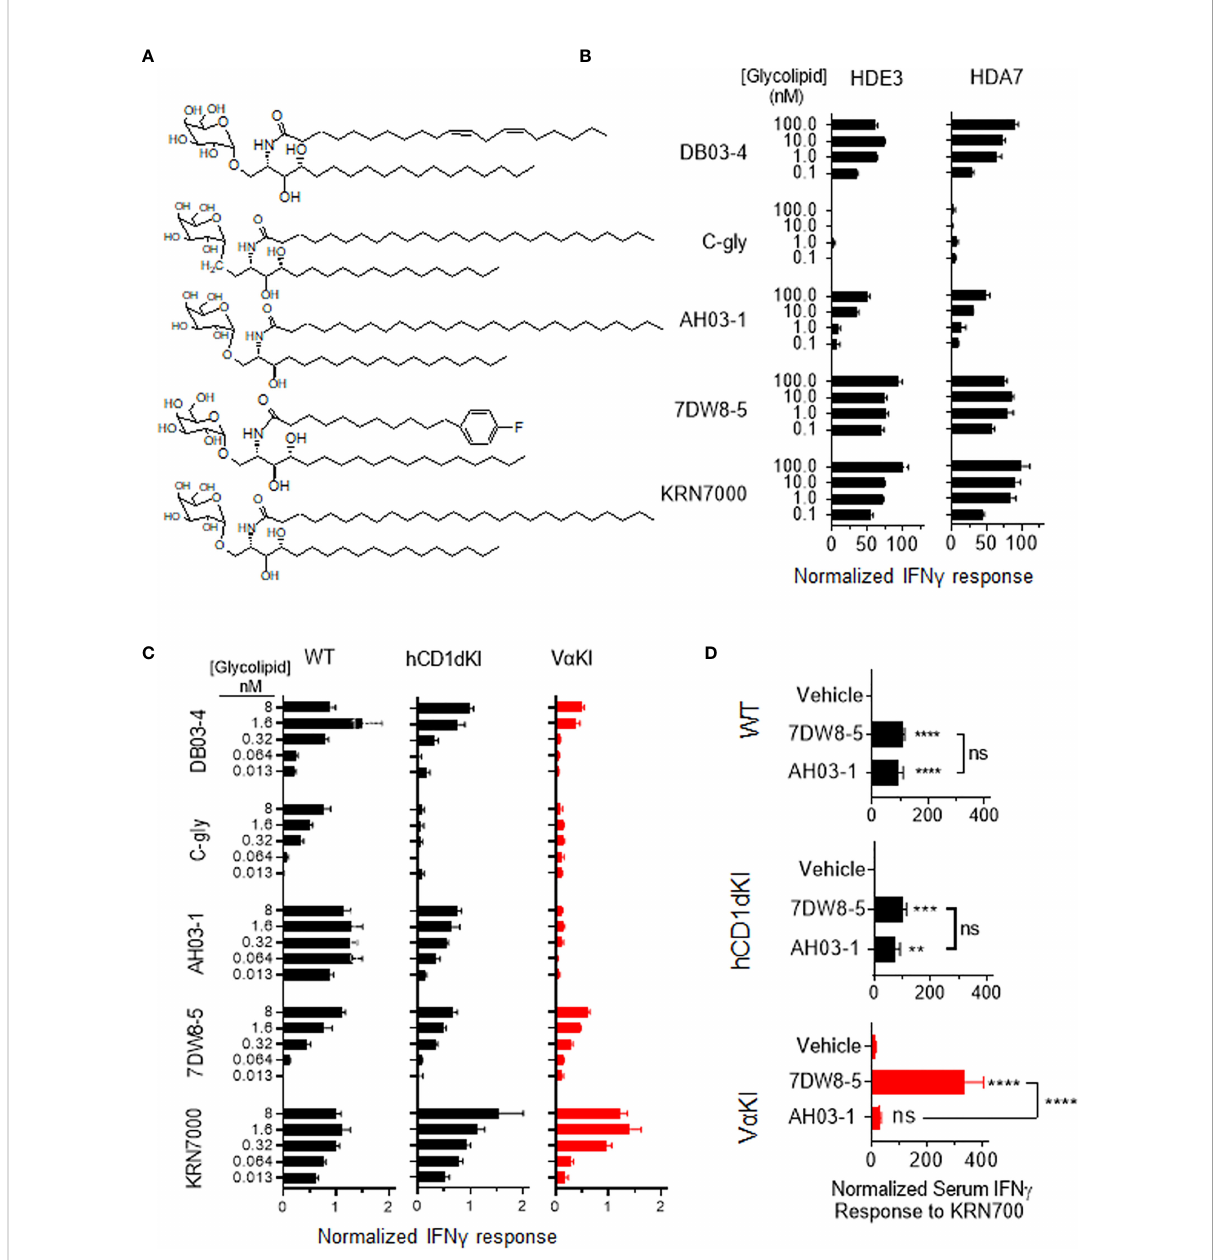
FIGURE 7 Human-like response of V a KI iNKT cells to a GalCer analogues. (A) Structures of glycolipids DB03-4, C-glycoside (C-gly), AH03-1, 7DW8-5 and KRN7000. (B) Human iNKT cell clones HDE3 and HDA7 were stimulated with different concentrations of glycolipids in cultures with hCD1d transfected HeLa cells as APCs. After 48 h, IFN g concentrations in supernatants were determined by ELISA and normalized to levels induced by 100 nmol KRN7000. (C) One million spleen cells from WT, hCD1dKI or V a KI mice were stimulated in culture with the indicated concentrations of glycolipids. After 72 h, IFN g concentration in the media was determined by ELISA and results were normalized to levels obtained with 40 nanomoles of KRN7000. (D) Four nanomoles of glycolipids (AH03-1 or 7DW8-5) or an equal volume of inert vehicle were administered i.v. into WT, hCD1d or V a KI mice. After 24 h, sera were collected and the concentration of IFN g determined by ELISA. Asterisks in D indicate comparisons of glycolipids to vehicle, except for those associated with brackets which compare the two glycolipids to each other. **P < 0.01, ***P < 0.001, ****P < 0.0001, ns, no signi fi cant (one-way ANOVA with Tukey